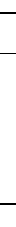
Table 1. The variations of Gibbs free energy ( ∆ G ) of the hydrolysis reaction of N -(rhodamine-6G)lactam-ethylenediamine-4-dimethylamino-cinnamaldehyde (RLED), and of the intermediate complexation/decomplexation processes in the hydrolysis reaction of RLED (at the B3LYP/LanL2DZ level of theory; 298 K; water; kcal/mol).